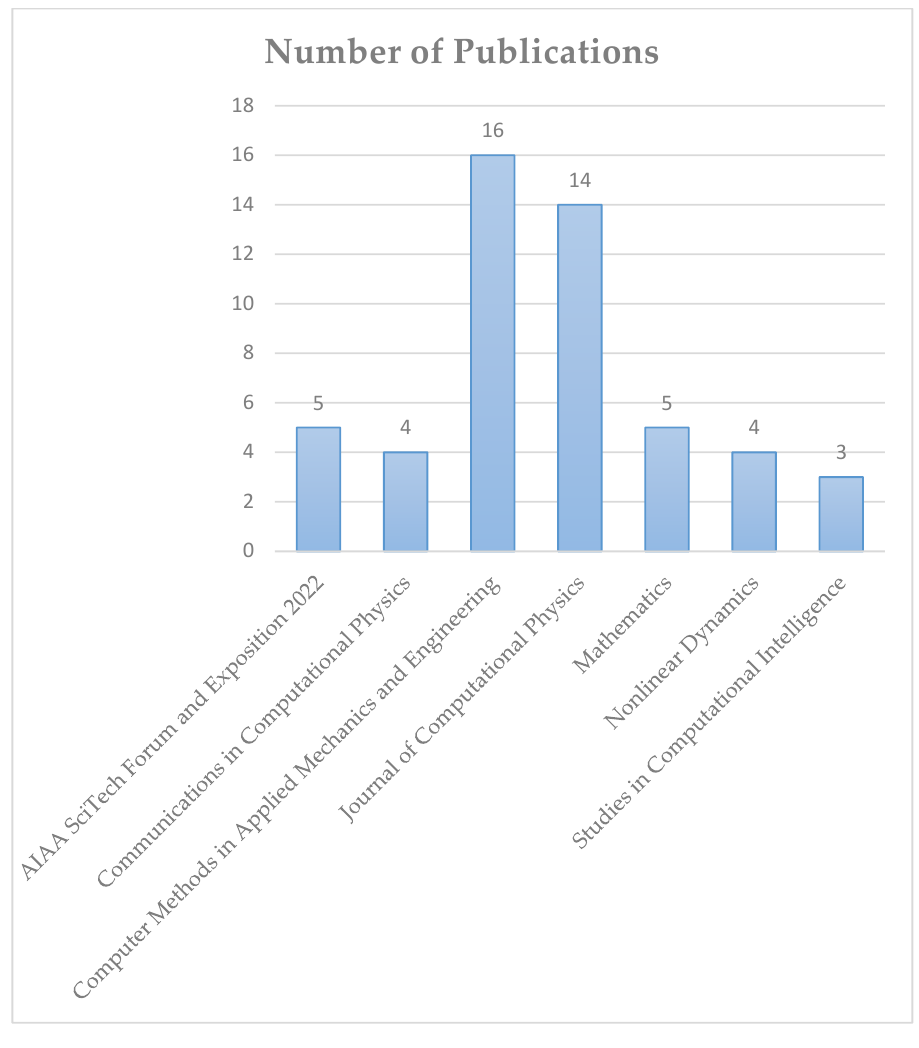
Figure 6. Journals with the most publications. Table 2. Authors with the most